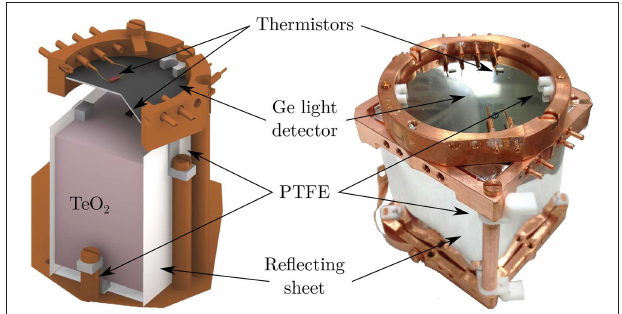
FIGURE 11 | Example of TeO 2 bolometers coupled to light detectors, allowing for a simultaneous measurement of heat + light signals. The crystals are wrapped with a reflecting foil to maximize light collection. Figures from Artusa et al. [11] and Casali et al.